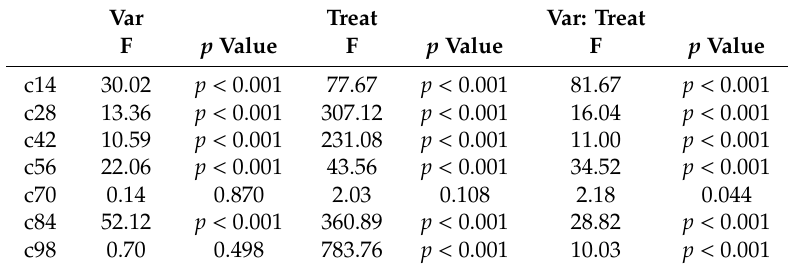
Table 4. Singular and combined e ff ect of variety x treatment interaction on the stage increases in